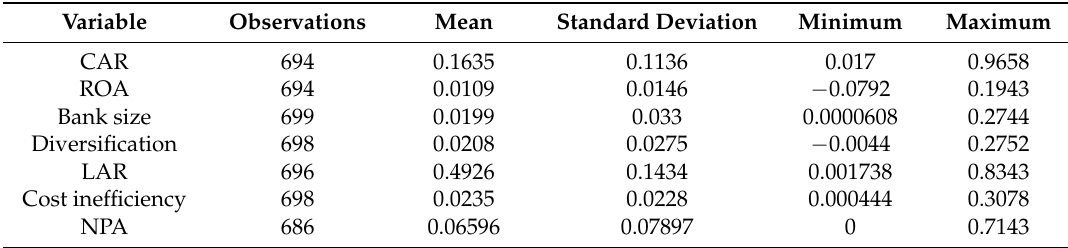
Table 2. Statistical description of the